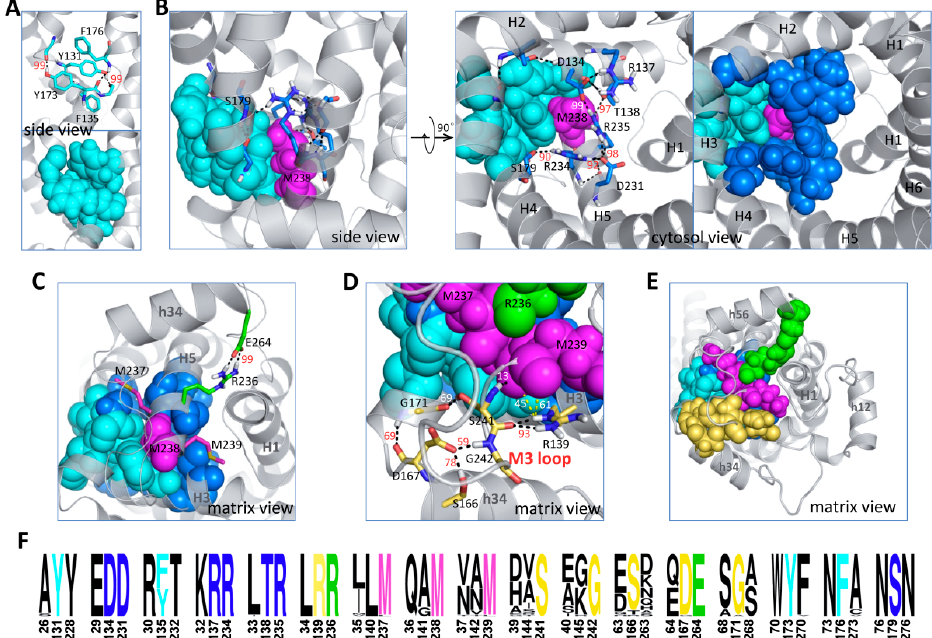
Figure 9. A highly asymmetric stable core exists in domains 2 and 3 of c-state apo AAC. ( A ) The interlocked aromatic cluster formed between the [YFW][KR]G motif residues and proline kink residues in domain 2. The side chains of C128 and Q174 are not shown for clarity purposes. ( B ) The interlocked aromatic cluster and the H3H4H5 network wrap tightly around M238. Occupancies for some bonds are shown in red or white numbers, and for complete data, please refer to our previous work [22]. ( C ) The matrix view of the positions of M237, M239 and the stable R236:E264 salt bridge. ( D ) The N-end of M3 is clamped by domain 2 through an exquisite electrostatic network. ( E ) The c-core residues are asymmetrically distributed. ( F ) The sequence logo presentation of the c-core residues within their triplets. In ( A – F ), the interlocked aromatic cluster in domain 2 is shown in cyan; the H3-H4-H5 network is shown in blue; MMM is shown in magenta; the R236:E264 salt bridge is shown in green; and the network between domain 2 and the N-end of the M3 loop is shown in light orange. Residues are shown first as sticks (with only polar hydrogen atoms) to highlight the interactions and then in spheres (with all hydrogen atoms) to show the space occupancy.